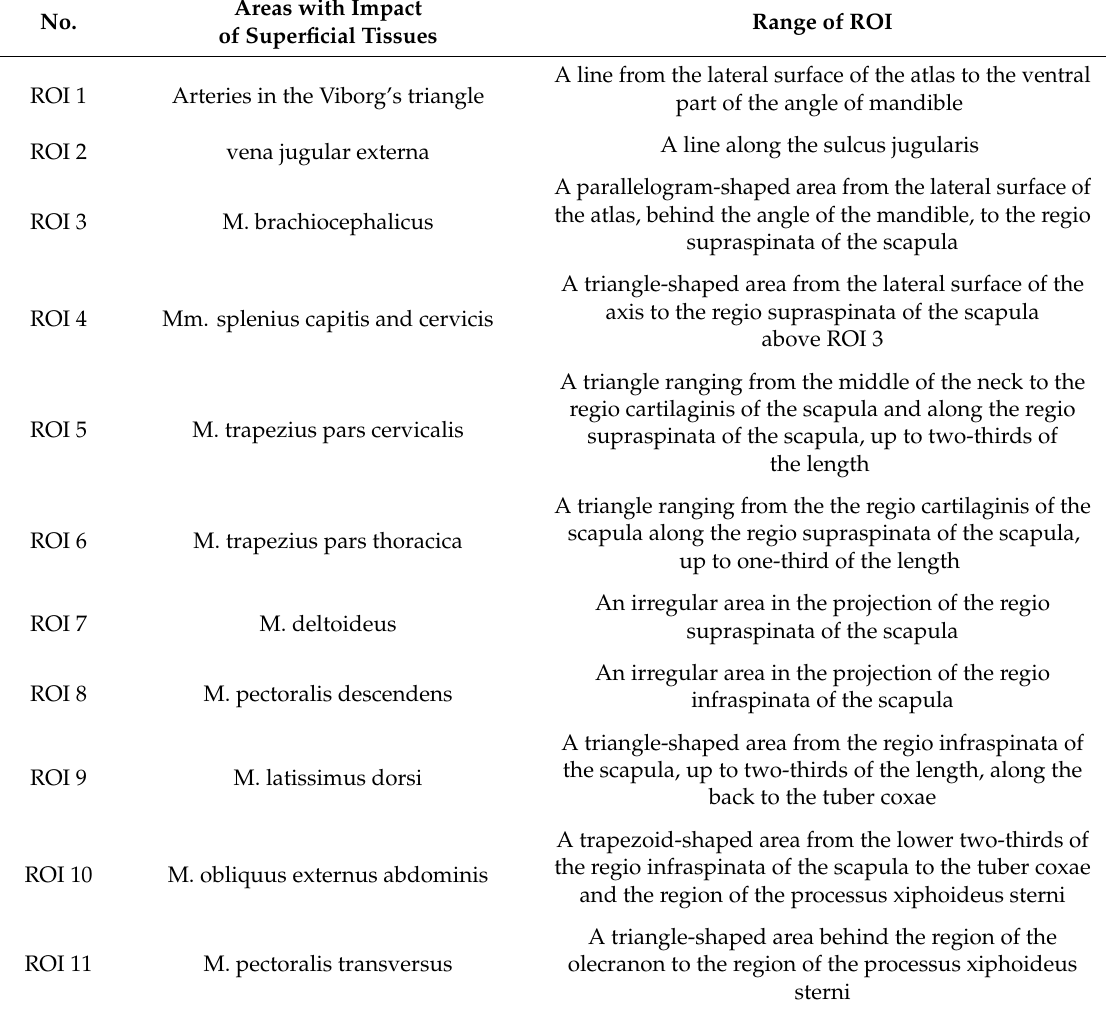
Table 1. The characteristics of the regions of interest (ROIs) taken into consideration during the body surface temperature evaluation.